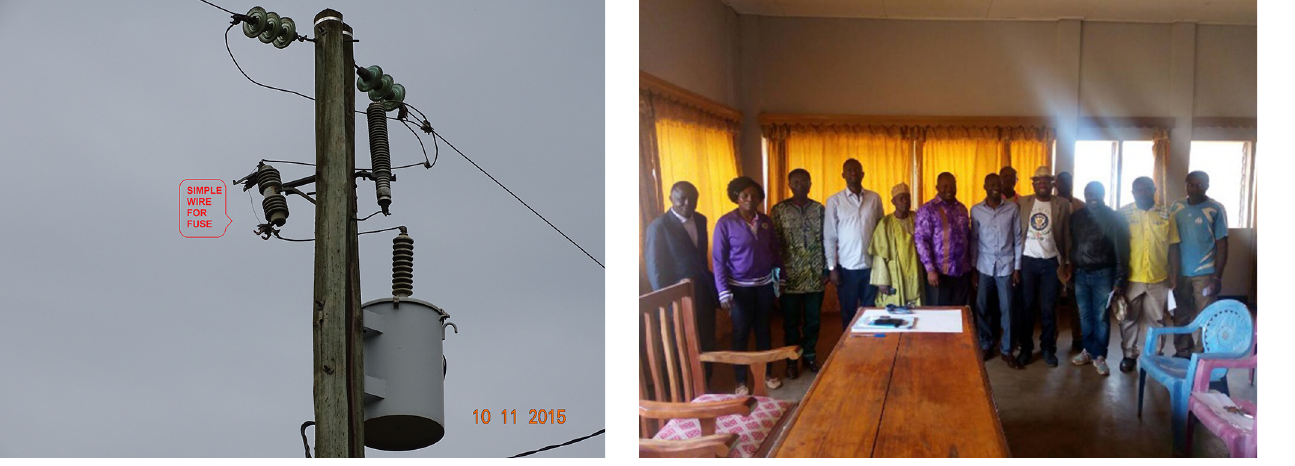
Fig. 16. Stakeholders ’ consultation for a micro hydro site in Dschang